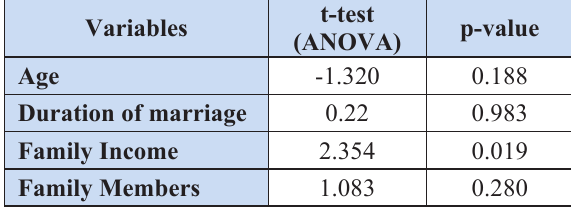
Table-4: Test of Variance (ANOVA) for age, duration